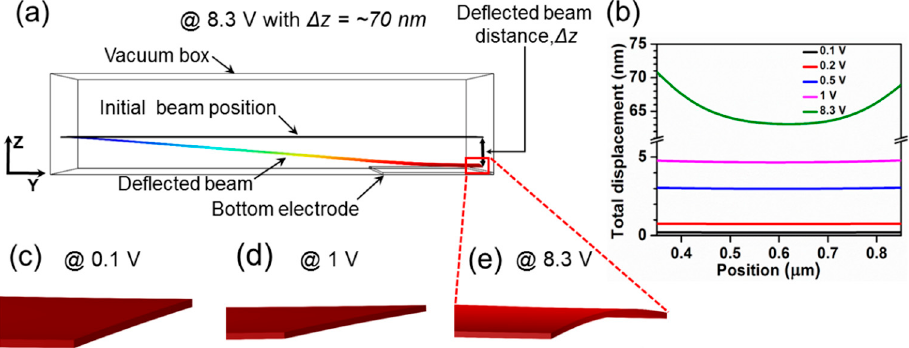
Figure 7. Effect of the beam edge electric field termination at 8.3 V. ( a ) The displacement of the beam at 8.3 V shown as side view; ( b ) The displacement of the beam from initial position at different applied voltages. Birds-eye cross-sectional view of the graphene beam at ( c ) 0.1 V; ( d ) 1 V; and ( e ) 8.3 V.